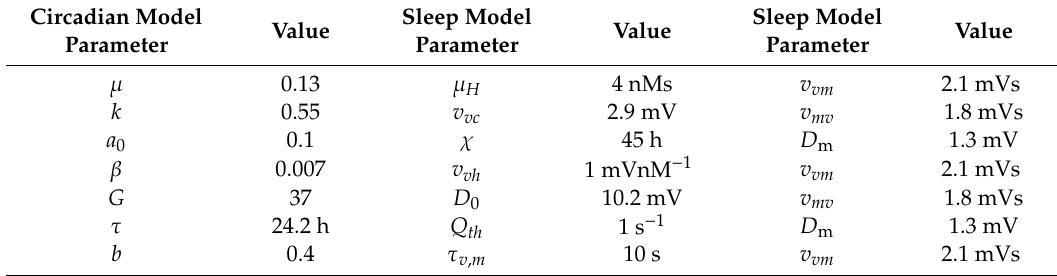
Table 1. Model parameter